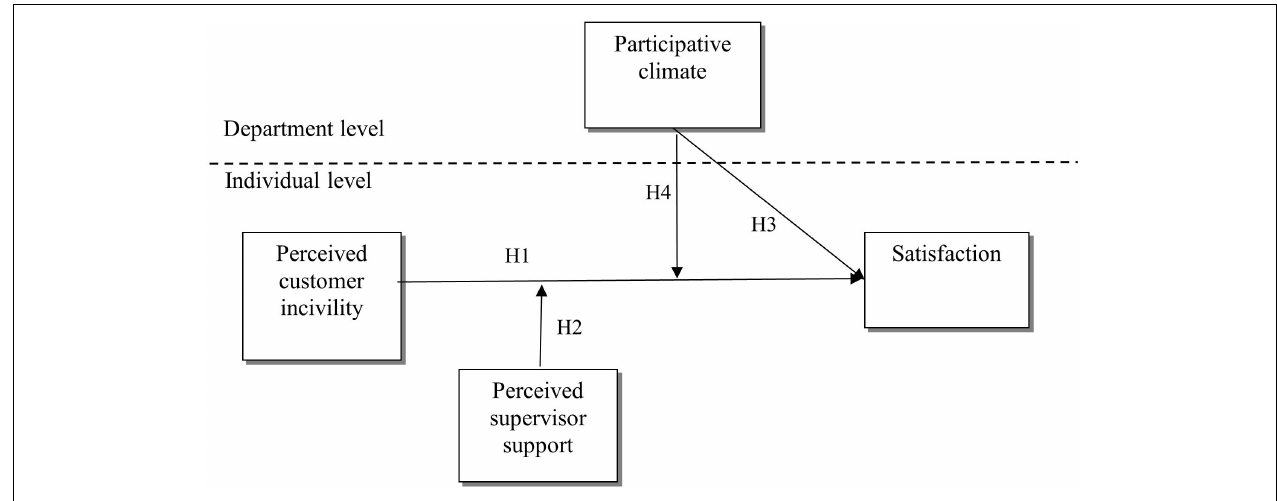
FIGURE 1 | A multi-level model of perceived customer incivility, satisfaction, supervisor support, and participative